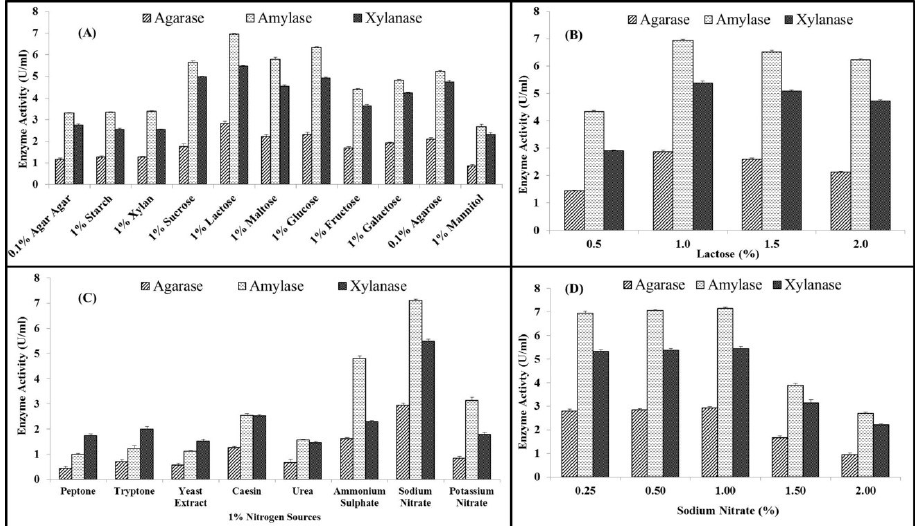
Figure 5. Effect of ( A ) Carbon sources ( B ) Lactose concentrations ( C ) Nitrogen sources ( D ) Sodium Nitrate